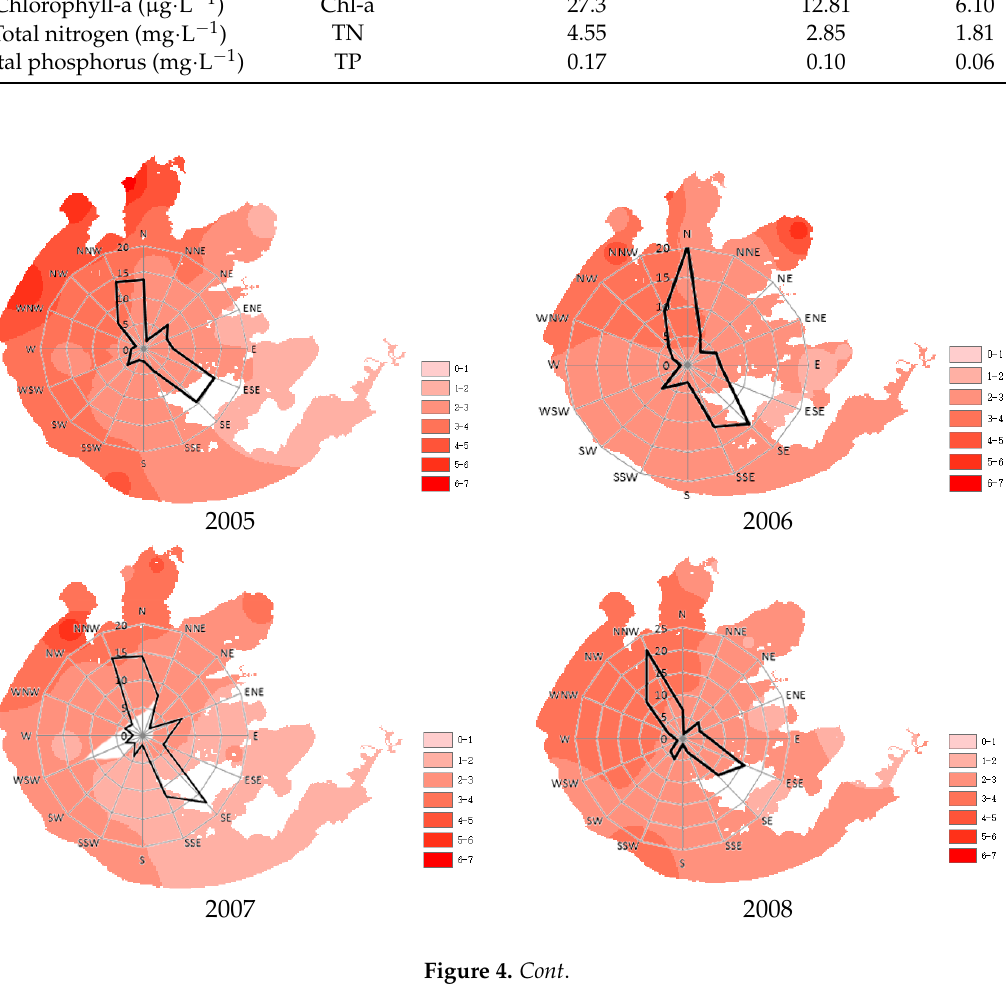
Table 2. Water quality from January 2005 to September 2011 in the zones (Figure 1) of Lake Tai. Water Quality Water